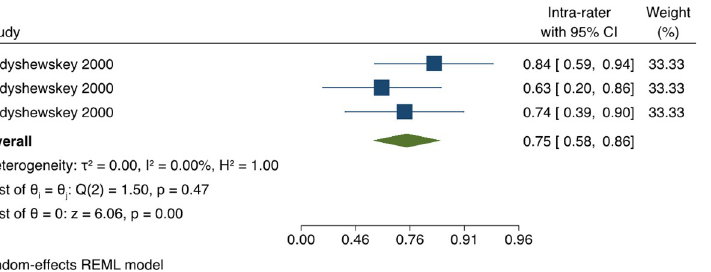
Fig 8. Meta-analysis of kappa coefficient for intra-rater reliability between standardised patients on OSCE’s in physical therapy students. Forest plot presenting the meta-analyzed estimate on kappa coefficient. Each square presents the results of an individual study with the size of the square being proportional to the weights used in the meta-analysis and the horizontal lines indicating the 95% confidence intervals. The solid diamond indicates the overall summary